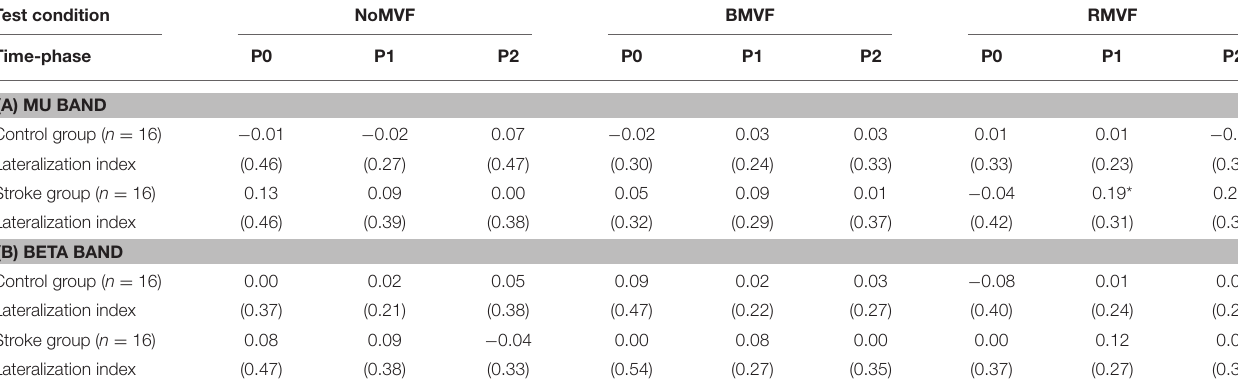
TABLE 2 | Lateralization analyses among the three conditions in the mu band and the beta band. Test